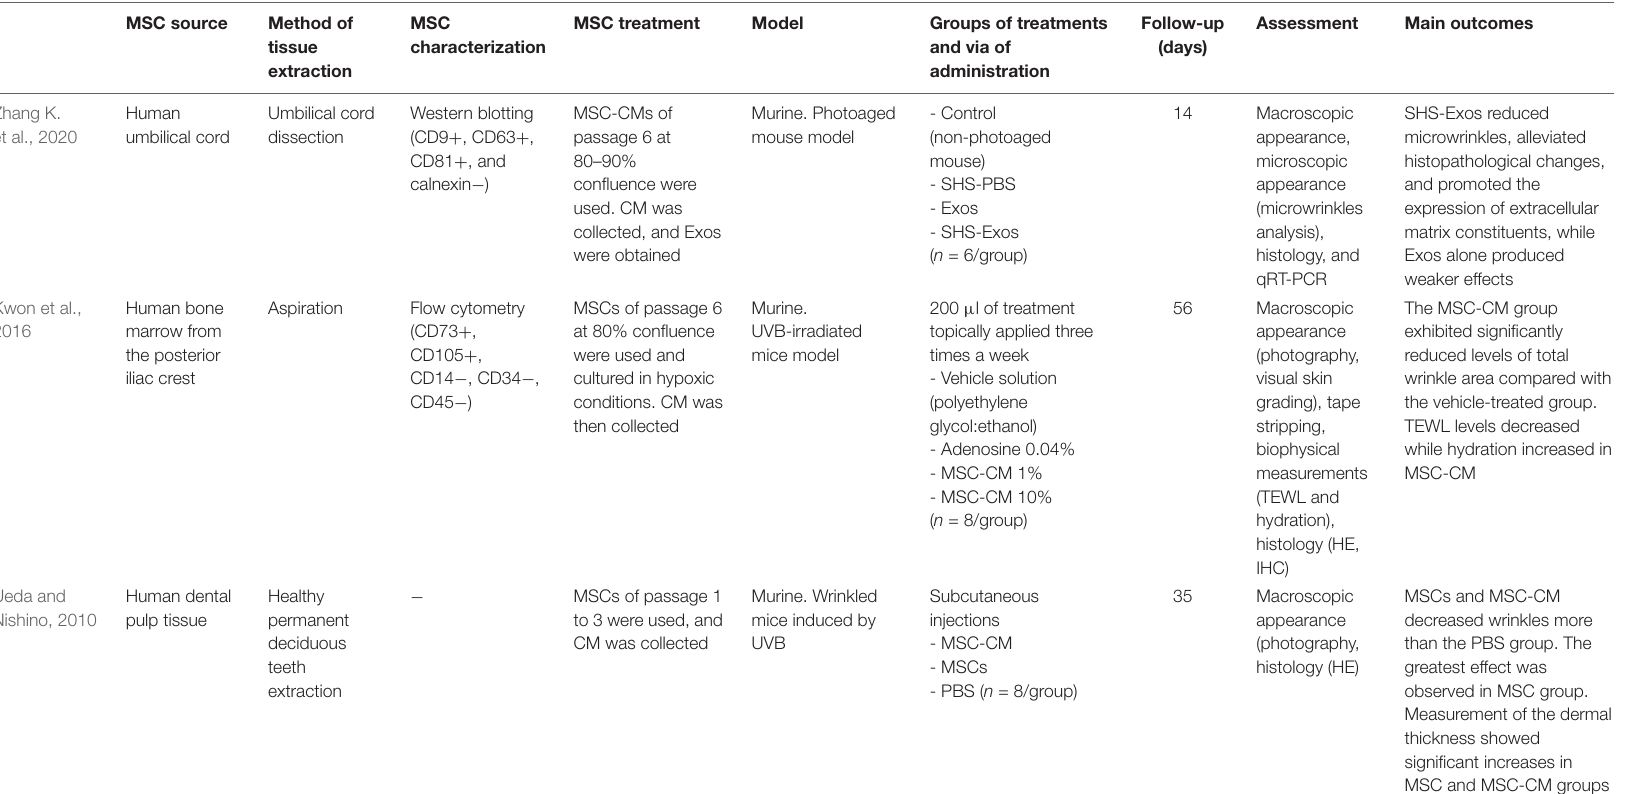
TABLE 9 | Studies regarding mesenchymal stromal cell-conditioned medium for skin rejuvenation in animal